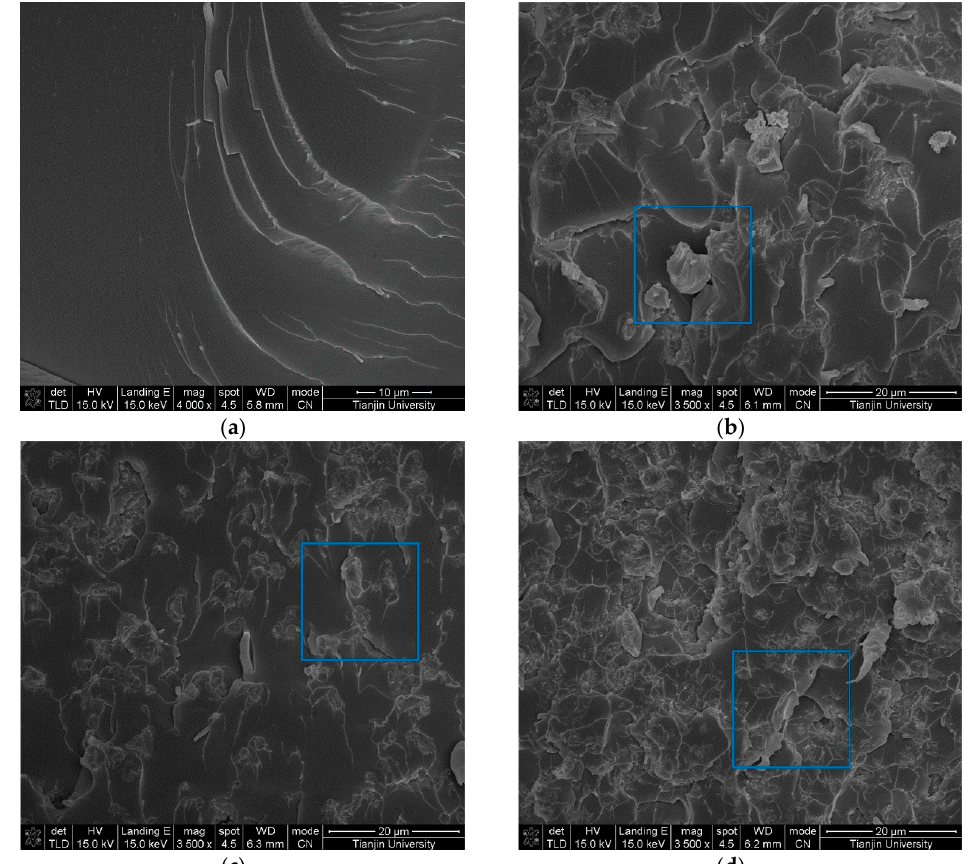
Figure 3. Scanning electron microscope (SEM) images of the epoxy composites filled with SiC particles of different filler content. ( a ) SiC of 0 phr, ( b ) α -SiC of 90 phr, ( c ) β -SiC of 60 phr, ( d ) β -SiC of 120 phr.